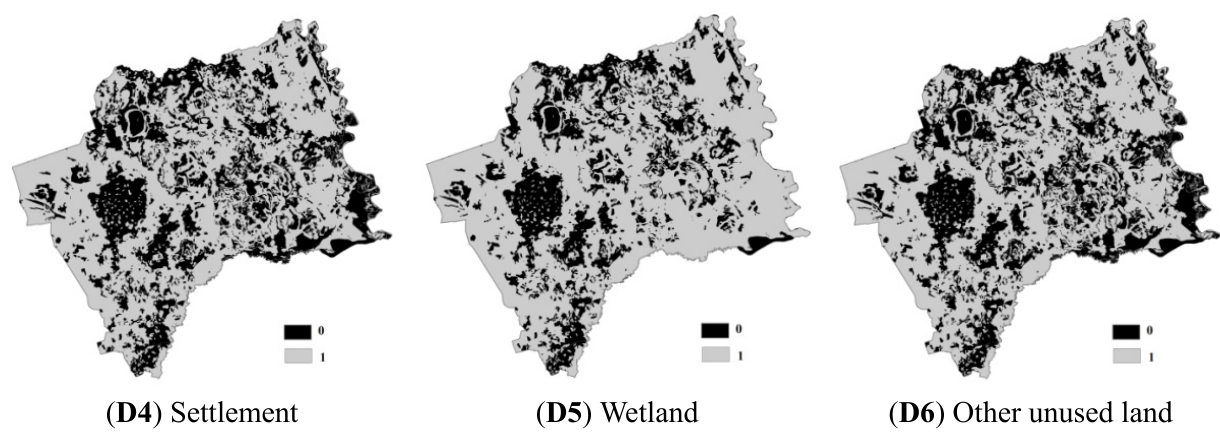
Figure 4. Factors for suitability maps ( A1 )–( A5 ); spatial auto correlation distance factors ( B1 )–( B6 ); and constraint images for ( C ) water and ( D1 )–( D6 ) unchanged land-covers.